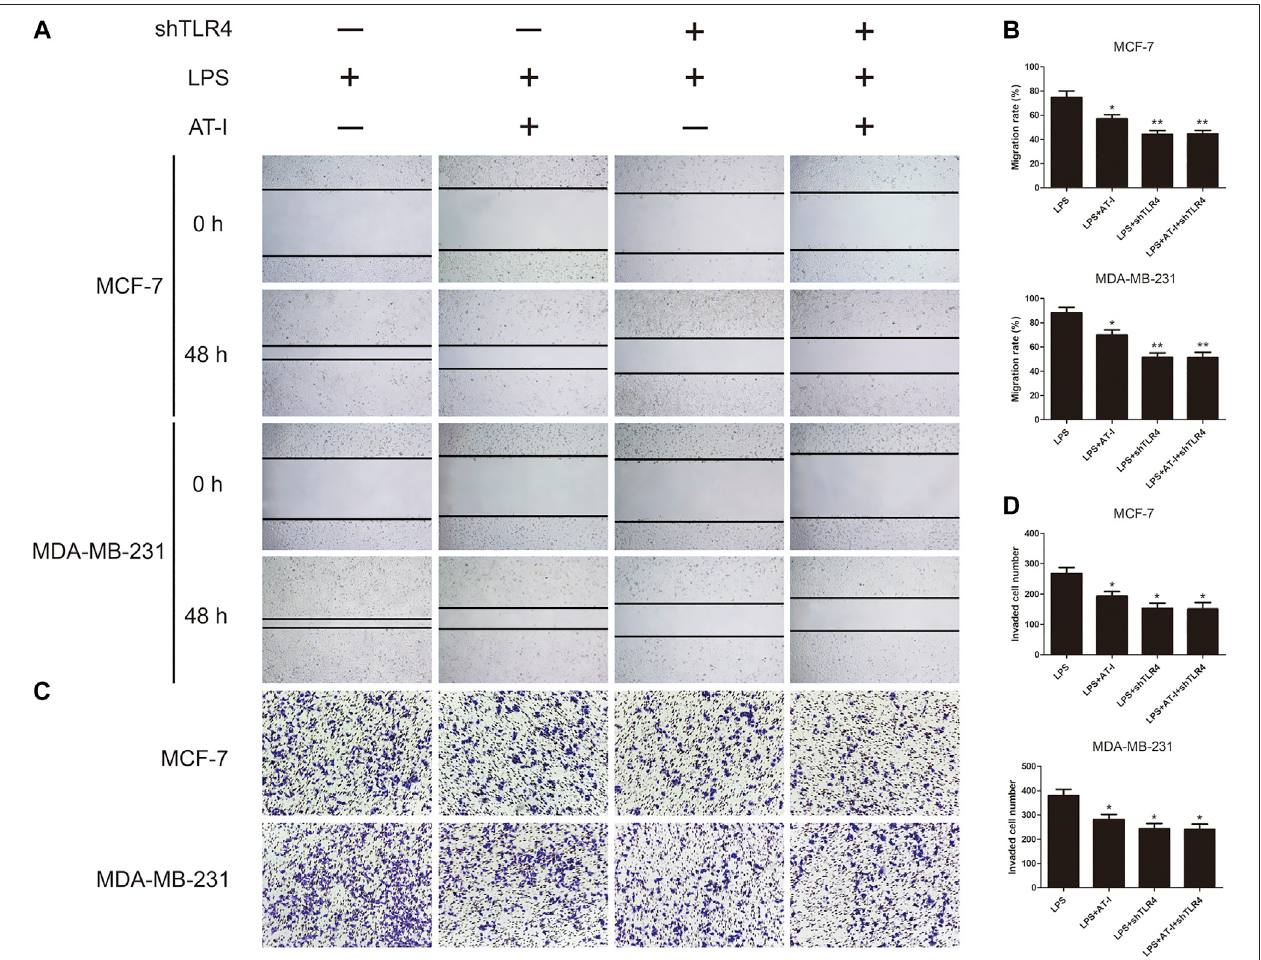
FIGURE6| TheeffectsofAT-IoncellmigrationandinvasionwasmediatedbyTLR4.LPSinducedshTLR4transfectedandcontrolcellsweretreatedwithAT-I,and then seeded in24-well plates ortranswellchambercoated withmatrigel. (A,B) The migrationcapabilitywerecalculatedbywound healingassay(40 × magni fi cation). (C, D) Theinvasion capability werecalculatedbytranswellinvasion assay(100 × magni fi cation).Signi fi cantdifferences between differentgroups were indicatedas* p < 0.05, ** p < 0.01, vs. the LPS treated control group, n (cid:1) 3.